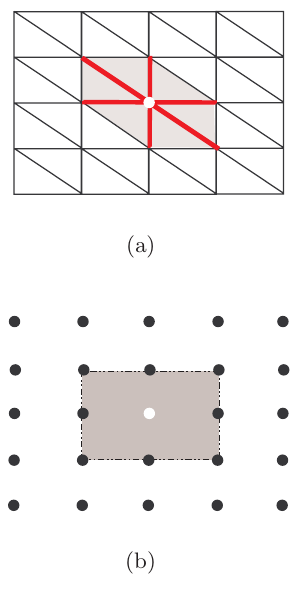
Fig. 9. Anisotropic neighborhood determination.